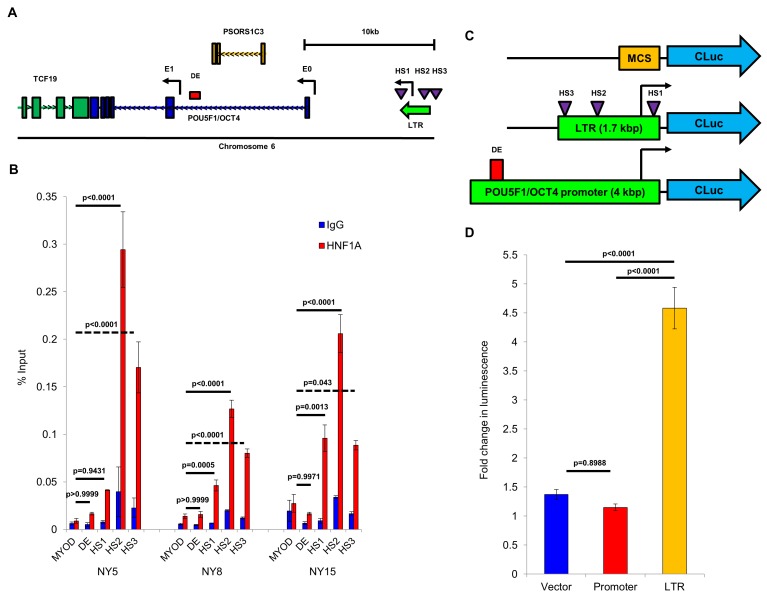
HNF1A binds directly to and activates transcription from the POU5F1/OCT4 upstream LTR region.(A) Schematic representation of the POU5F1/OCT4 locus, including the canonical exon 1 (E1), distal enhancer region (DE), and the cryptic exon E0 and upstream LTR regions reported in Malakootian et al. (2017). Putative HNF1A half-sites (HS) are indicated by purple triangles. (B) Chromatin immunoprecipitation (ChIP) was performed in NY5, NY8, and NY15 cells using and HNF1A-specific antibody or normal IgG control. Enrichment of the MYOD promoter (negative control), the POU5F1/OCT4 distal enhancer (DE), or the three HNF1A half-sites (HS1-3) was measured by quantitative PCR and normalized to a 2% input control. Statistical difference was determined by one-way ANOVA with Tukey’s multiple comparisons test, and comparisons to enrichment of MYOD by HNF1A are shown. (C) Schematic representation of Cypridina luciferase (CLuc) reporter constructs, including the cloning vector, a reporter containing the LTR from Malakootian et al. (2017) expanded to include the third HNF1A half-site, and a containing the fulllenght canonical POU5F1/OCT4 promoter region. Relative positions of HNF1A half-sites (HS) and the distal enhancer (DE) are indicated. (D) 293FT cells were transfected with 0.5 µg of either the CLuc cloning vector, LTR reporter, or canonical promoter reporter in combination with 0.5 µg of either LacZ or HNF1A expression plasmid and 0.05 µg of a HSV-TK promoter-driven Gaussia-Dura luciferase (GDLuc) expression plasmid for normalization. After 48 hr, conditioned media was collected and secreted CLuc and GDLuc activity was measured. Fold change in CLuc luminescence from HNF1A-transfected cells relative to LacZ-transfected cells is shown (mean ± SEM, n = 3). Statistical difference was determined by one-way ANOVA with Tukey’s multiple comparisons test.